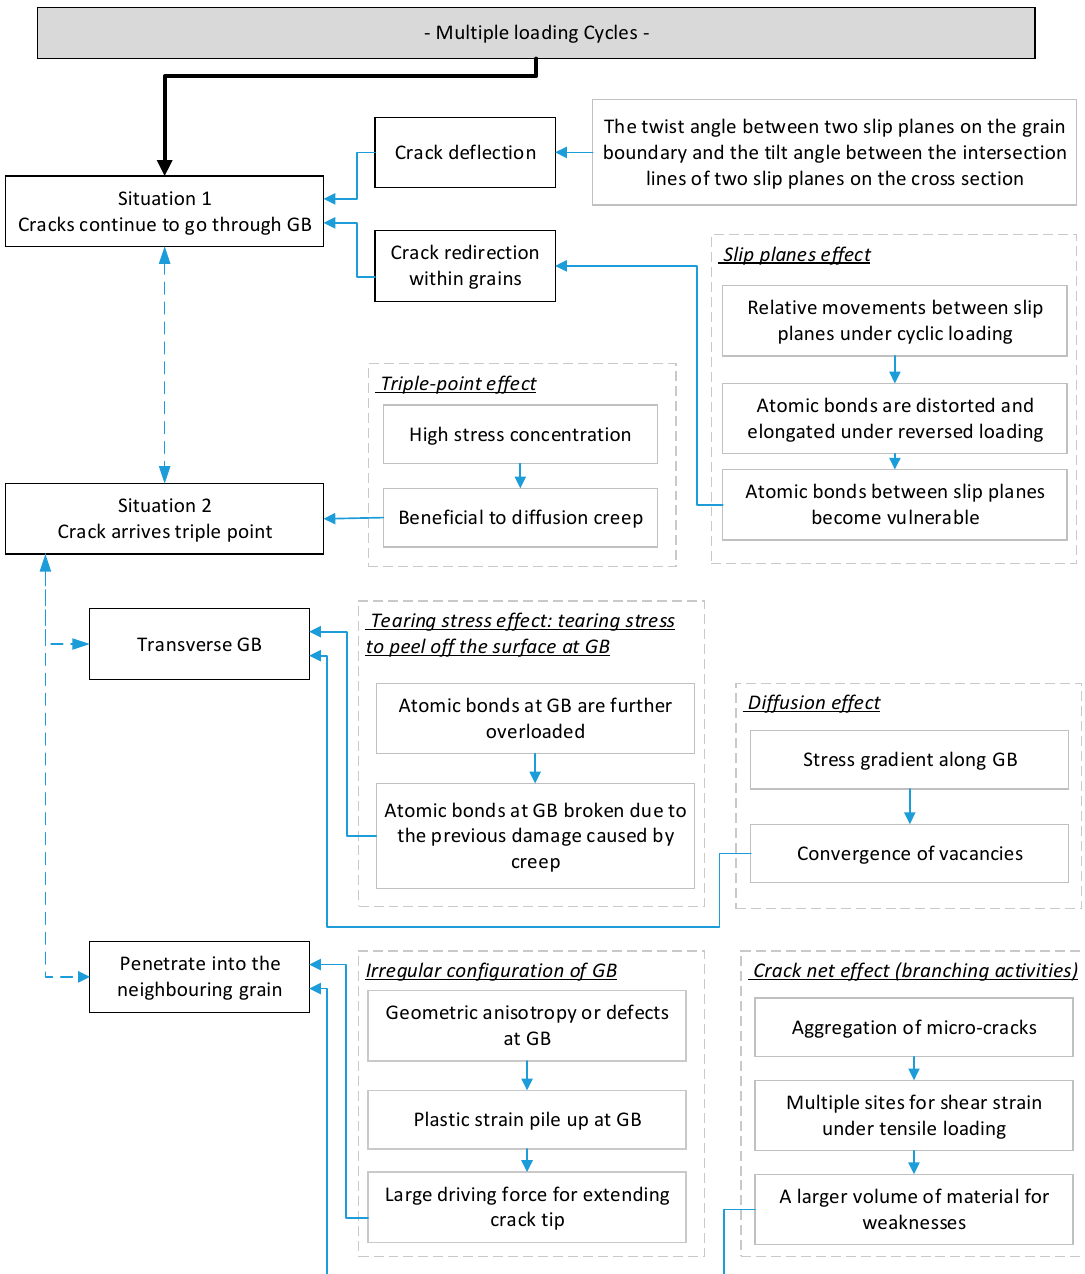
Figure 19. Key elements for multiple load cycles in the stage of crack propagation. Metals 2018 , 8 , x FOR PEER REVIEW